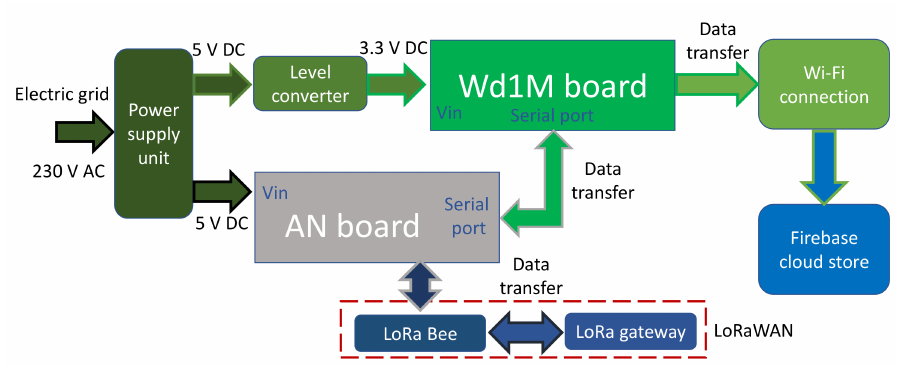
Figure 2. Block diagram of the